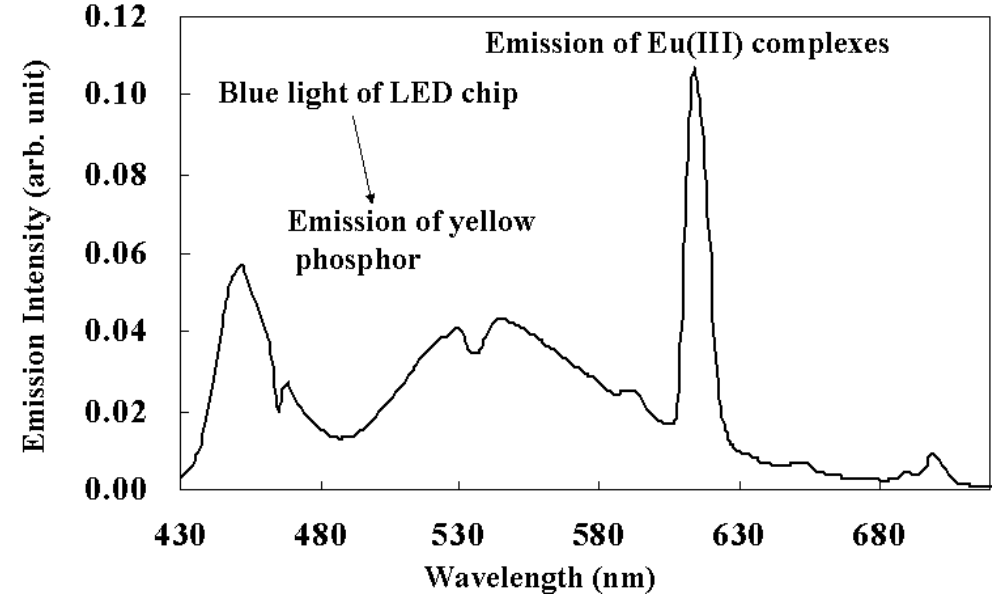
Figure 21. The emission spectra of white LED devices using Eu(III) complexes with two different phosphine